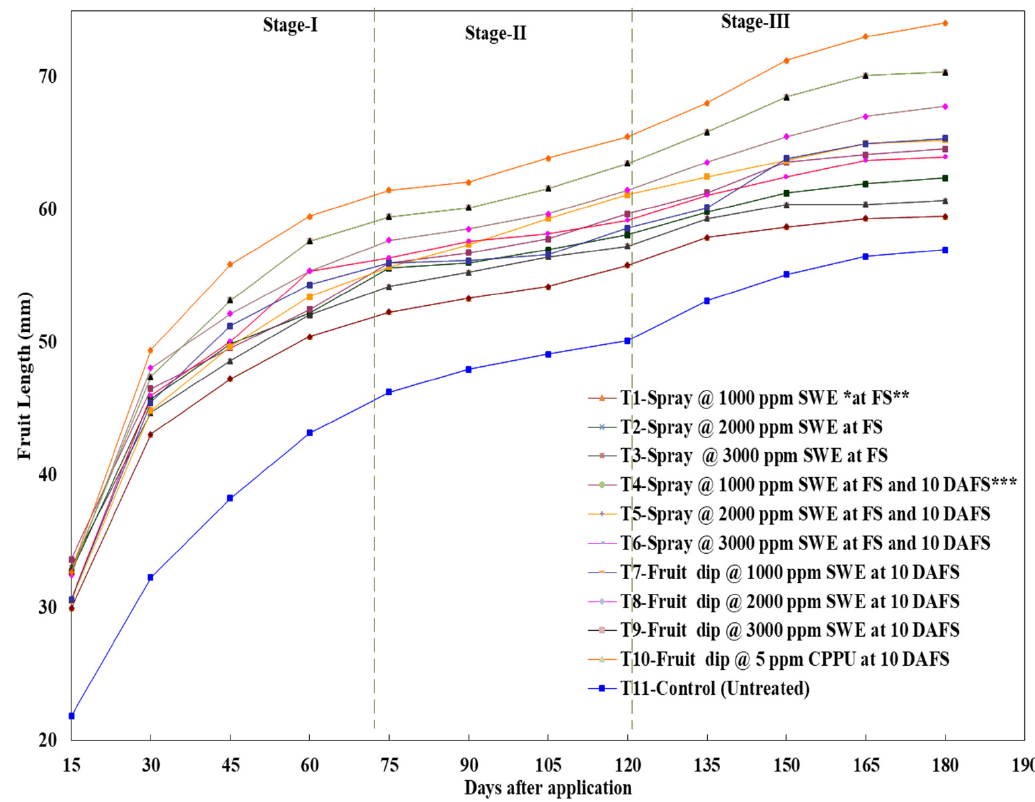
Figure 1. Impact of seaweed extract on the fruit growth pattern of kiwifruit in terms of length. SWE